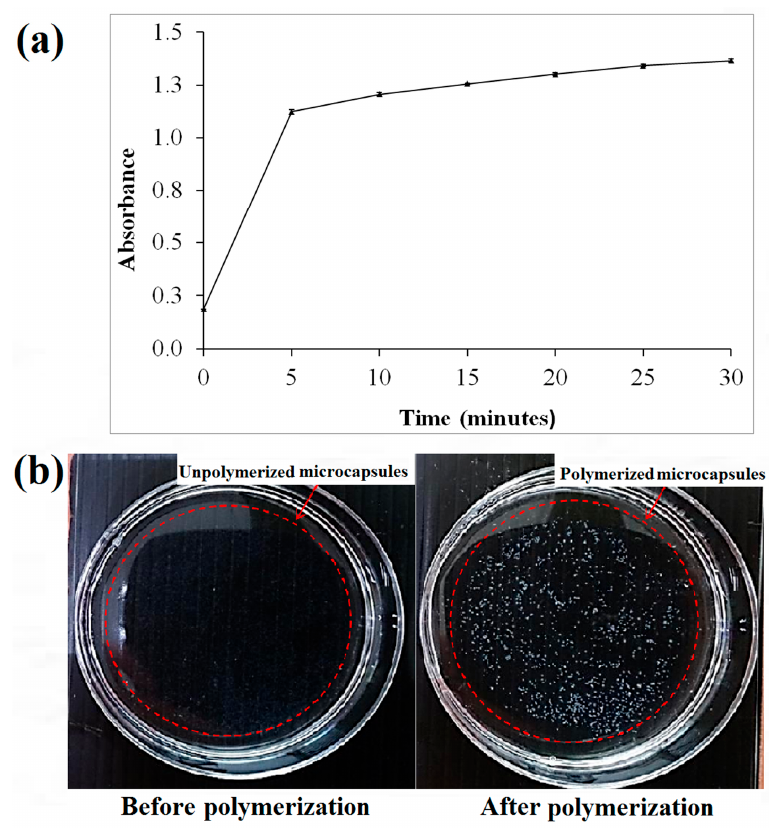
Figure 2. ( a ) The polymerization absorbance of the microcapsules upon irradiation at 330 nm; ( b ) Images of calcium alginate microcapsules before and after polymerization. Figures 3a,b show the growth and transition of morphological changes of 3D HaCaT and ORL- 48 cells in the microencapsulation of calcium alginate over a period of 16 days, respectively. The 3D cells of HaCaT and ORL-48 cells were observed to have grown gradually into the microtissues after approximately 16 days of culture. On the first day of culture (Day 0), the HaCaT and ORL-48 cells (Figure 3) were scattered in the calcium alginate microcapsules. From Day 2 onwards, the quantity of cells encapsulated in the calcium alginate microcapsules increased and continued to form aggregates in the encapsulations (Figure 3). After approximately 14 days of culture, the clusters of cells in the microcapsules grew into microtissues and the masses of cells completely filled the microcapsules. Towards day 16 of culture, the grown microtissues of HaCaT and ORL-48 can be clearly seen with dark appearance representing a high density of microtissues.